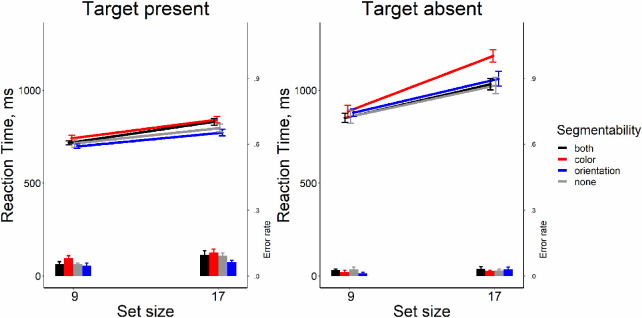
Reaction time and error rate as a function of set size and segmentability in Experiment 1. Error bars denote the SEM, with between-subject variance removed in accordance with the Cousineau (2005) method.